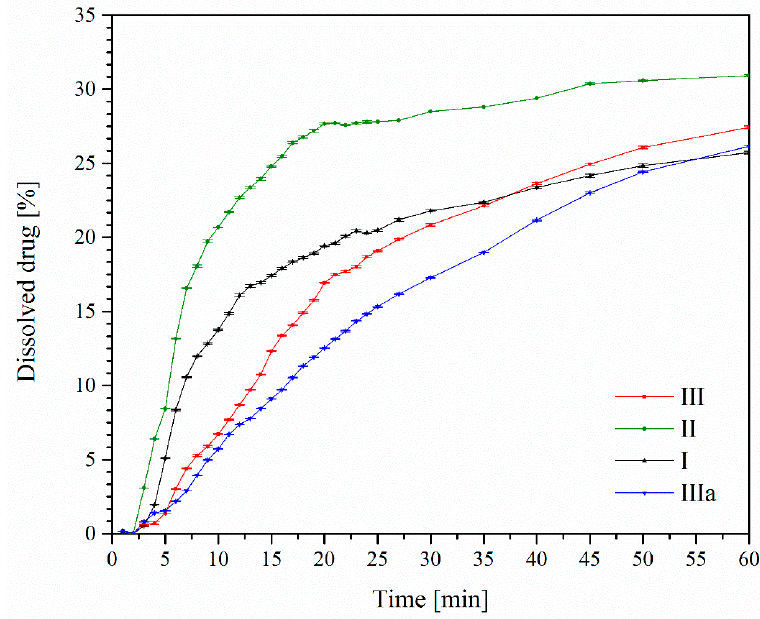
Figure 4. Apparent solubility profiles of benzocaine in phosphate buffer (pH ≈ 7.2).